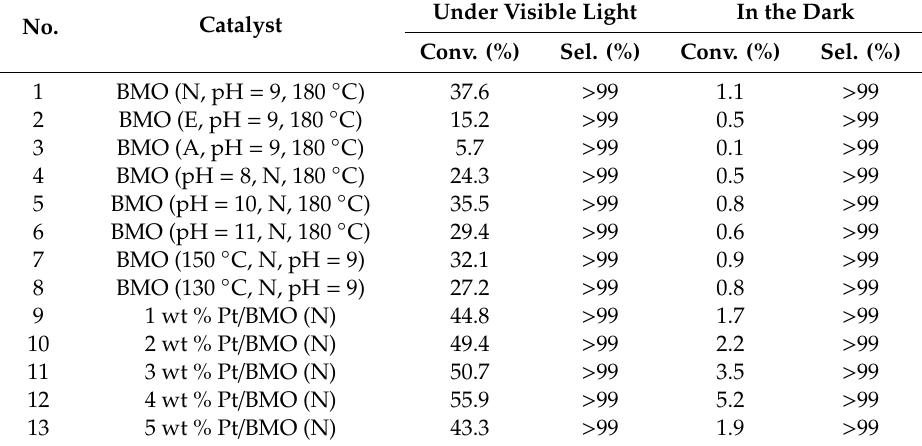
Table 2. E ff ect of the di ff erent catalysts on the reaction of benzyl alcohol and acetophenone. Under Visible Light In the Dark No. Catalyst Conv. (%) Sel. (%) Conv. (%) Sel.